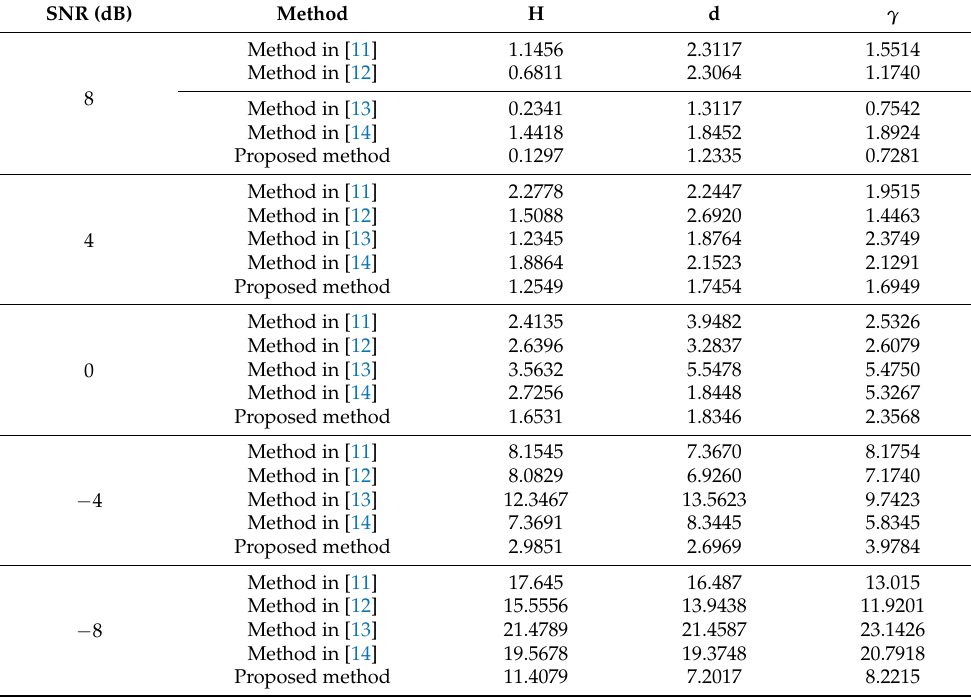
Table 3. MARE of estimated parameters with different methods.